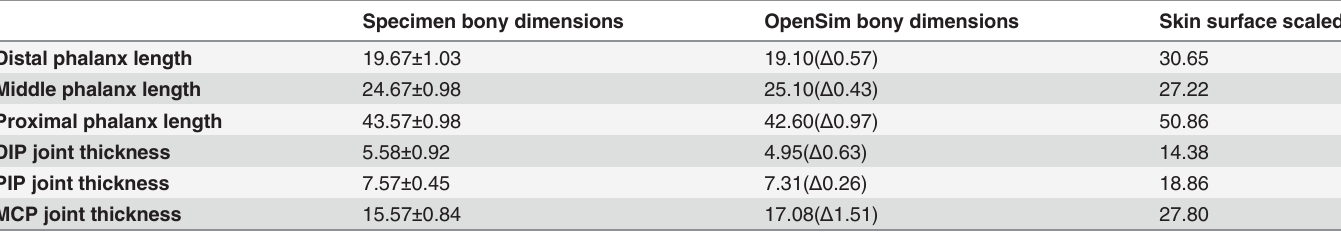
Table 1. Anthropometric index finger dimensions of cadaveric specimens [20] and OpenSim model (mm). Specimen bony